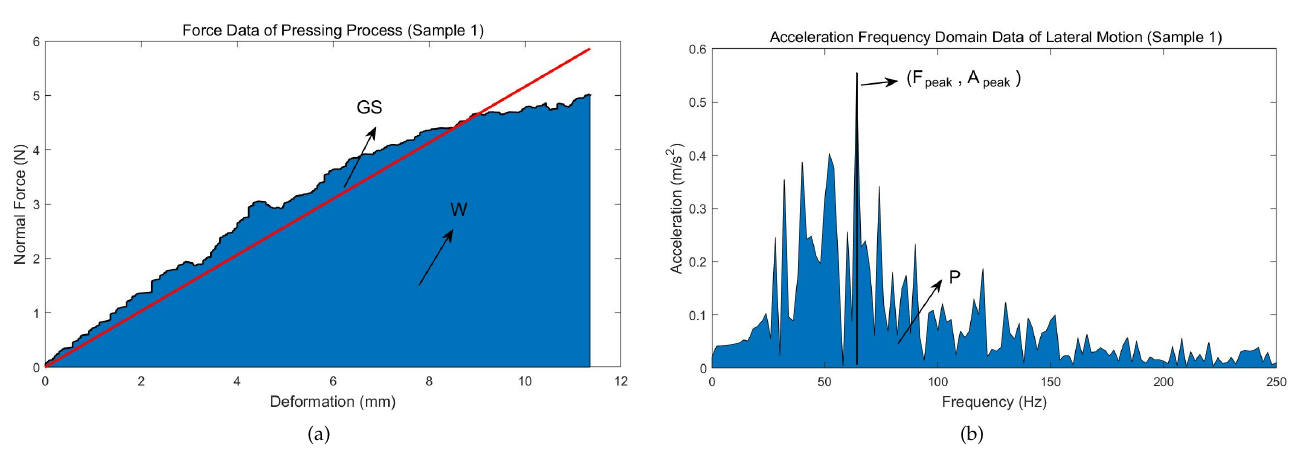
Figure 4. The interaction data and features of Sample 1 (S1) in the exploring process. ( a ) Force data and features GS , W in pressing process. ( b ) Acceleration frequency domain data and features F peak , A Fpeak , P during lateral motion.